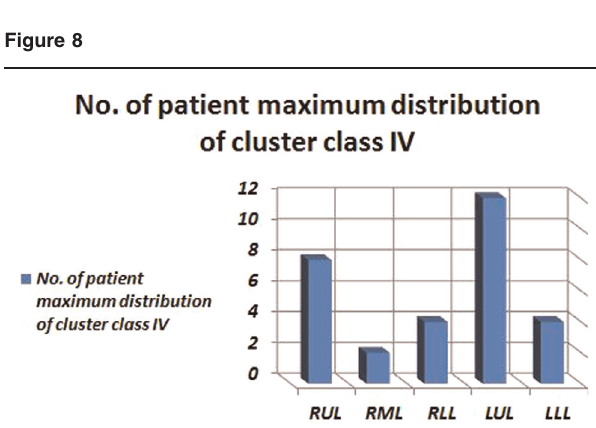
The pulmonary distribution of cluster class IV, which is the largest clusterbyvolume.LLL,leftlowerlobe;LUL,leftupper lobe;RLL,eight lower lobe; RML, right middle lode; RUL, right upper